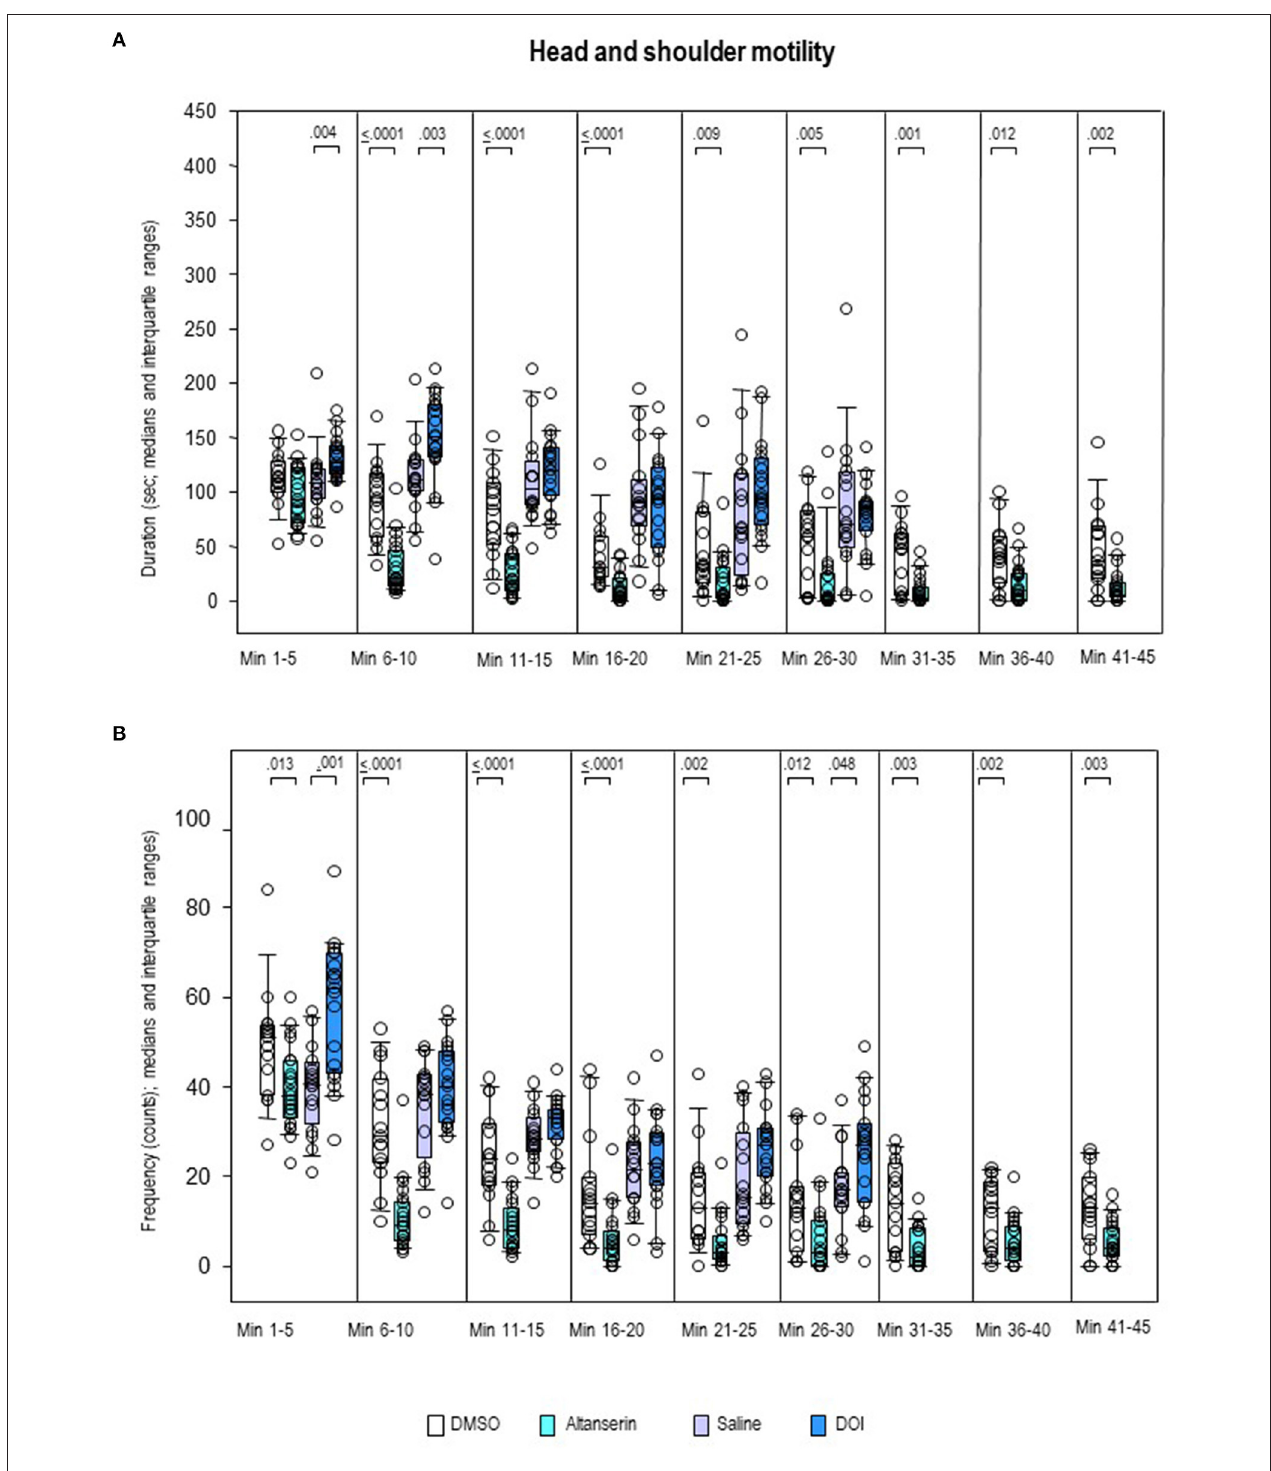
FIGURE 10 | Head–shoulder motility. Duration (s) and frequency (counts) after 10 mg/kg of altanserin (turquoise), 0.5 mg/kg of 2,5-dimethoxy-4-iodoamphetamine (DOI; blue), and the respective vehicles [dimethyl sulfoxide (DMSO), white; saline, light purple]. The figure shows box and whisker plots of median durations (A) and frequencies (B) in the individual 5-min bins. The 25th/75th percentiles are given in the boxes, while the 5th/95th percentiles are represented by the whiskers. The circles represent the individual animals. Groups (altanserin vs. DMSO; DOI vs. saline) were compared with the independent Mann–Whitney U -test (two-tailed, α = 0.05). Significant p -values are